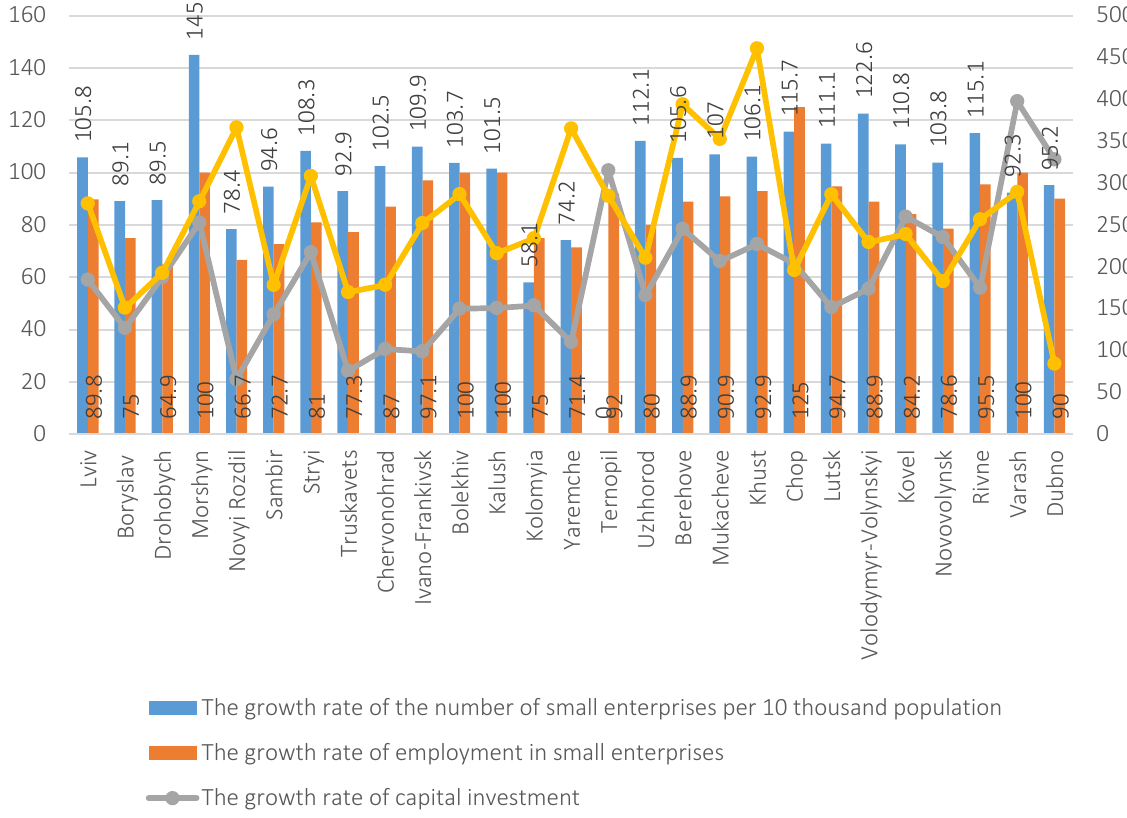
Figure 1. Dynamics of the development of small enterprises in the cities of regional significance in the Western region,